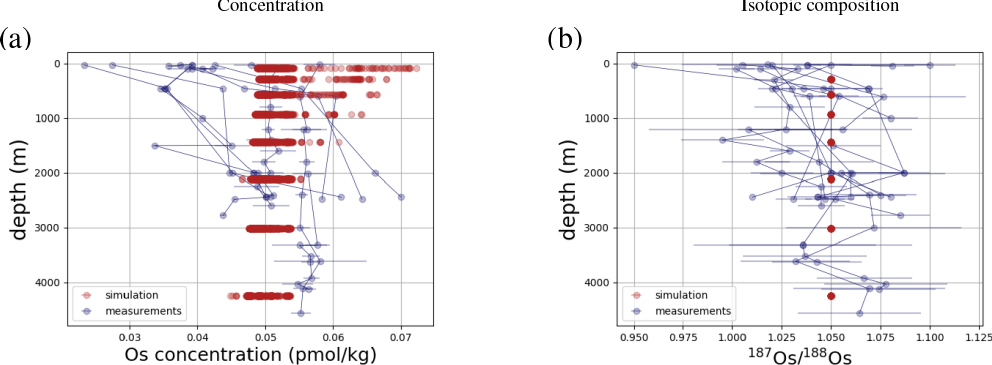
Figure F6. Comparison between measured and simulated Os vertical profiles in seawater. Composites of all available measured Os concen- tration (a) and isotope ratio (b) profiles and all profiles in the simulation are shown. Data are taken from Levasseur et al. (1998), Woodhouse et al. (1999), and Gannoun and Burton (2014).